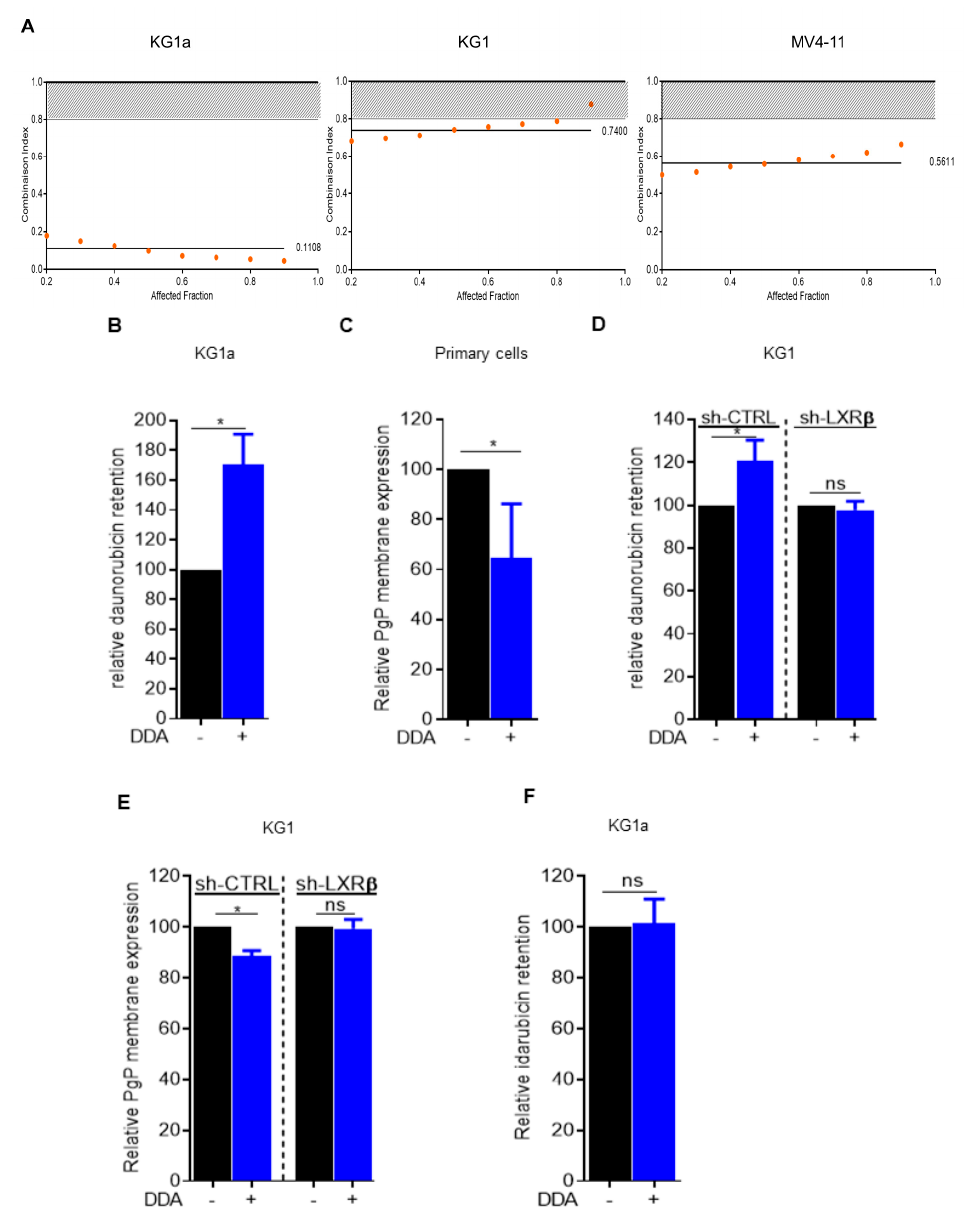
Figure 1. Combined dendrogenin A (DDA) and daunorubicin synergistically induce the death of AML cells. ( A ) Combination Index: CI < 0.80 indicates synergy of DDA with daunorubicin in KG1a, KG1, MV4-11 cells ( B ) Intra-cellular daunorubicin concentration was quantified by flow cytometry after 24 h of DDA treatment at 2.5 µ M. DATA were represented as % of intra-cellular daunorubicin concentration relative to vehicle treated cells. Bars are mean ± SD of 3 independent experiments. ( C ) PgP membrane expression was measured by flow cytometry after 48 h of DDA treatment at 2.5 µ M in four primary AML sample. Data were represented as % of PgP membrane expression relative to vehicle treated cells. ( D ) Intra-cellular daunorubicin concentration was quantified after 24 h of DDA treatment at 2.5 µ M in KG1-shctrl and Kg1-ShLXR β cells. Data were represented as % of intra-cellular daunorubicin concentration relative to vehicle treated cells. Points are mean ± SD of 3 independent experiments. ( E ) PgP membrane expression was measured after 24 h of DDA treatment at 2.5 µ M in KG1Shctrl and KG1-ShLXR β . Data were represented as % of PgP membrane expression relative to vehicle treated cells. Bars are mean ± SD of 3 independent experiments. ( F ) Intra-cellular IDA concentration was quantified by flow cytometry after 24 h of DDA treatment at 2.5 µ M. Data were represented as % of intra-cellular idarubicin concentration relative to vehicle treated cells. Bars are mean ± SD of 3 independent experiments. * p <